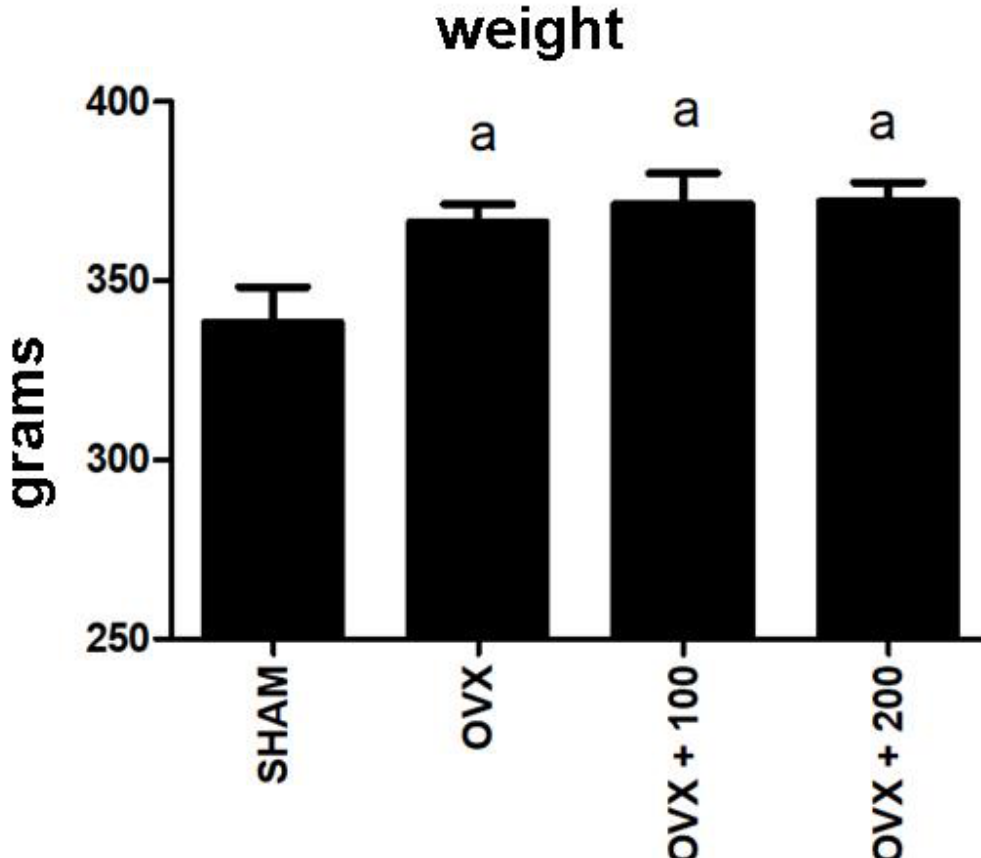
Figure 6. Weights at the end of the experiment. SHAM operated, ovariectomized (OVX), ovariectomized and treated with olive oil (OVX + 100) (100 µ L / day by oral gavage) and ovariectomized and treated with olive oil (OVX + 200) (200 µ L / day by oral gavage) over 3 months, n = 12. Data are expressed as mean ± SD. Statistical significance: ( a ) vs. SHAM; OVX vs. SHAM p < 0.05, OVX + 100 vs. SHAM p < 0.05, OVX + 200 vs. SHAM p < 0.01.